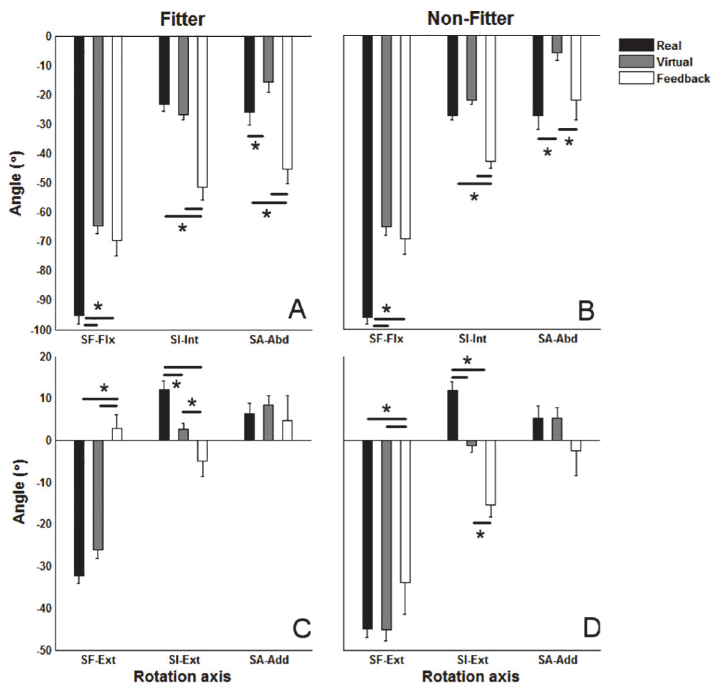
Fig 3. The mean and standard error of maximum of angle trajectories of shoulder flexion (SF), internal rotation (SI) and abduction (SA) across participants and cycles. The figures in each column illustrate the outcomes for each of the object types ( “ fitter ” and “ non-fitter ” ). SF, SI and SA stand for shoulder flexion, internal rotation and abduction, respectively. SF-Flx and SF-Ext stand for maximum flexion and extension of SF angle, SI-Int and SI-Ext stand for maximum internal and external rotation of SI angle, and SA-Abd and SA- Add stand for maximum abduction and adduction of SA angle. * indicate a significant pairwise comparison between Real, Virtual and Virtual environment with feedback (Feedback) (p <